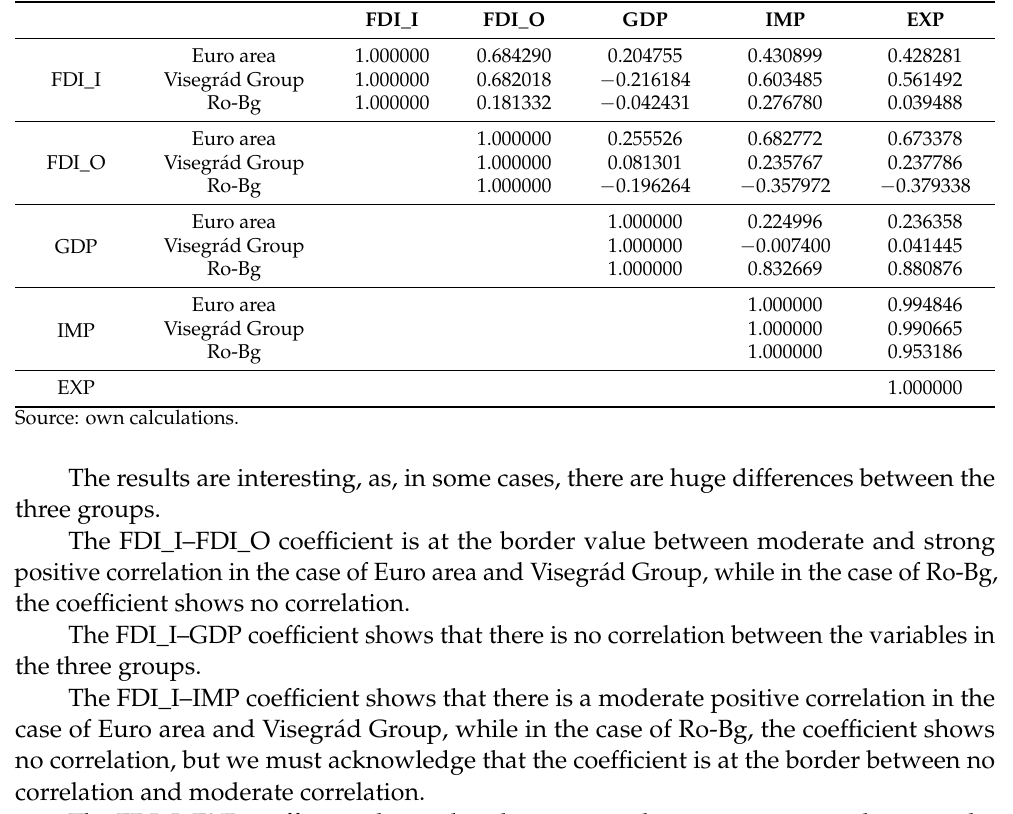
Table 2. Correlations